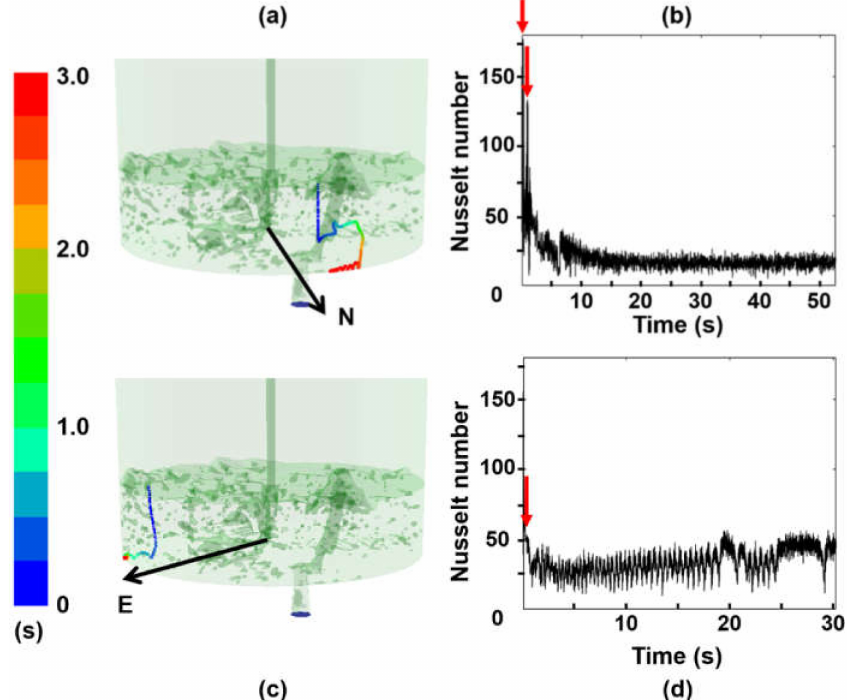
Figure 3. Particle trajectories, residence times, and Nusselt numbers at bath level of 16 tons. ( a ) A 3D view of the particle trajectory in the multiphase flow, the addition is in point N3. ( b ) Variations of the Nusselt number with time after the particle falls in point N3. ( c ) A 3D view of the particle trajectory in the multiphase flow, the addition is in point E3. ( d ) Variations of the Nusselt number with time after the particle falls in point E3. Steel superheat is 15